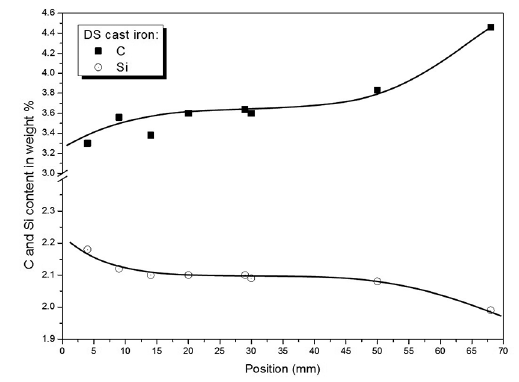
Figure 7: Carbon (C) and silicon (Si) profiles along the length of the DS